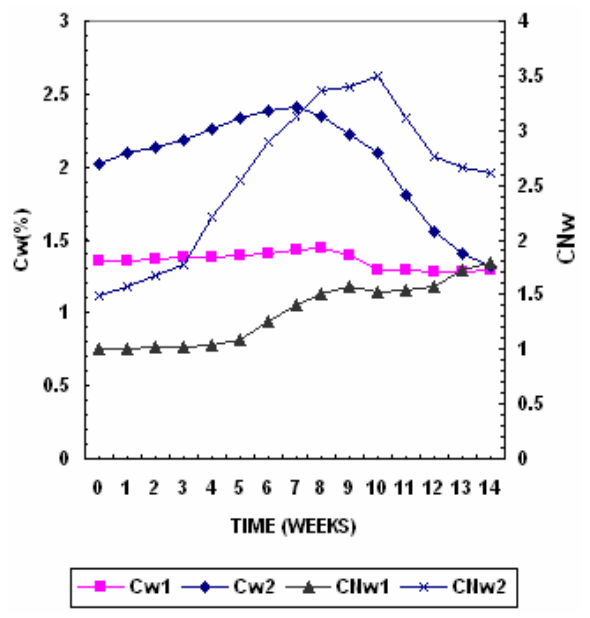
Fig 3: Variation of water soluble carbon and CNw during composting.